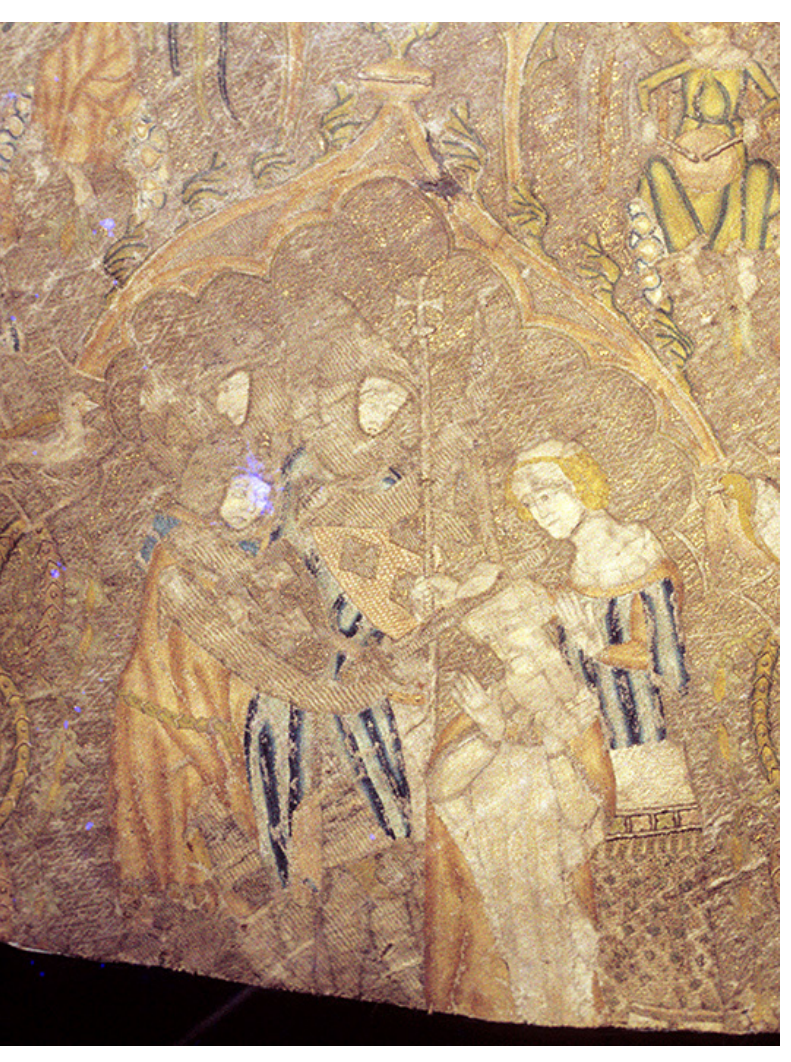
Figure 16. St John Lateran cope, first half of the 14th century, detail: Thomas Becket’s martyrdom. Roma, Lateran Museum, Italy. © Index of Medieval Art, Princeton.